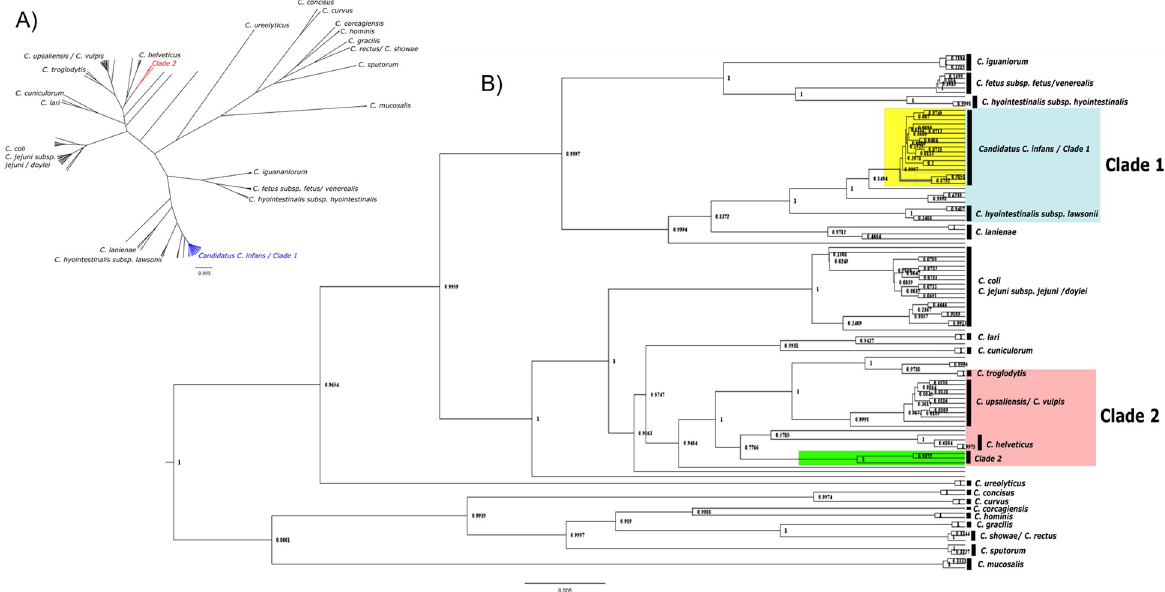
Fig 3. Phylogenetic tree of Campylobacter spp . showing all the detected and reference sequences [constructed using Bayesian inference (BEAST v 2.6.4) and visualized/edited using Figtree v 1.4.4]. A) Cladogram of Campylobacter spp . B) Phylogenetic tree constructed using detected and reference Campylobacter spp